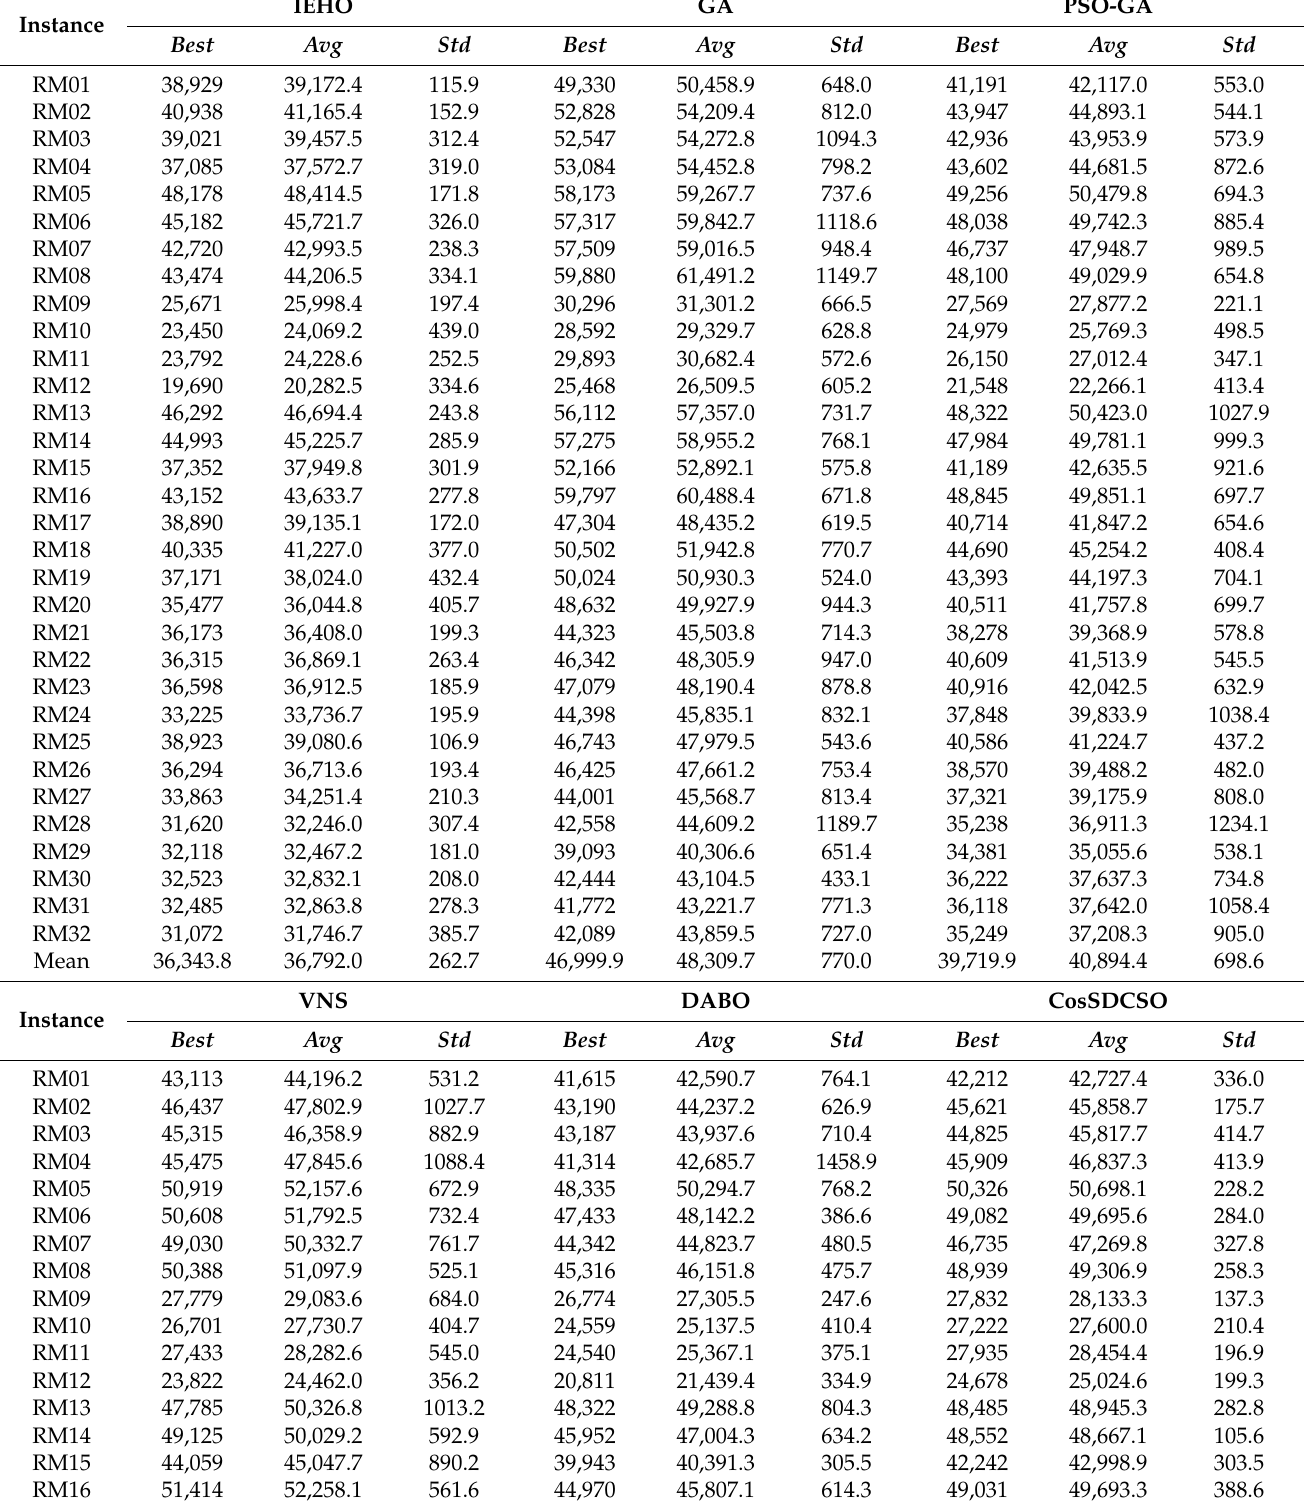
Table 8. Comparison results of IEHO and other